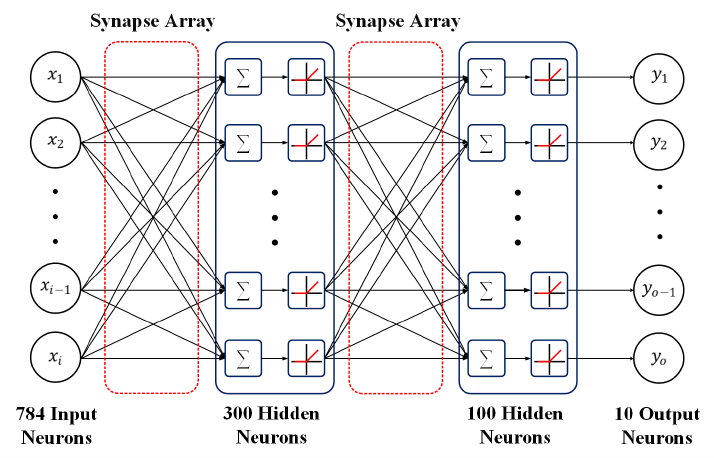
Figure 7. The architecture of the neural network used in the experiment; The network consisted of two hidden layers with 300 and 100 hidden neurons and one output layer with 10 output neurons. ReLU is used as an activation function.